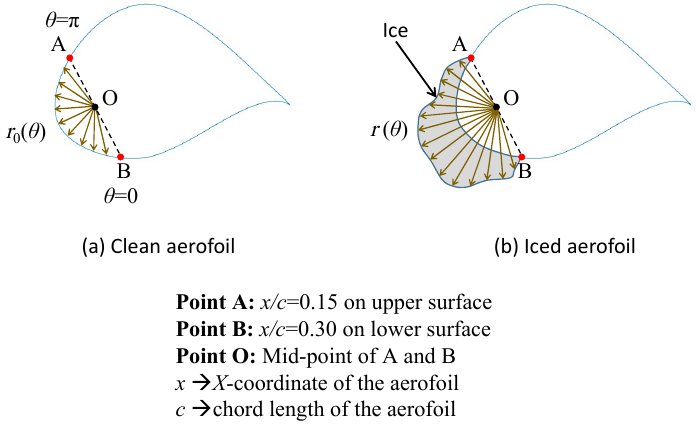
Figure 2. Parametric modeling of the ice shape on an aerofoil